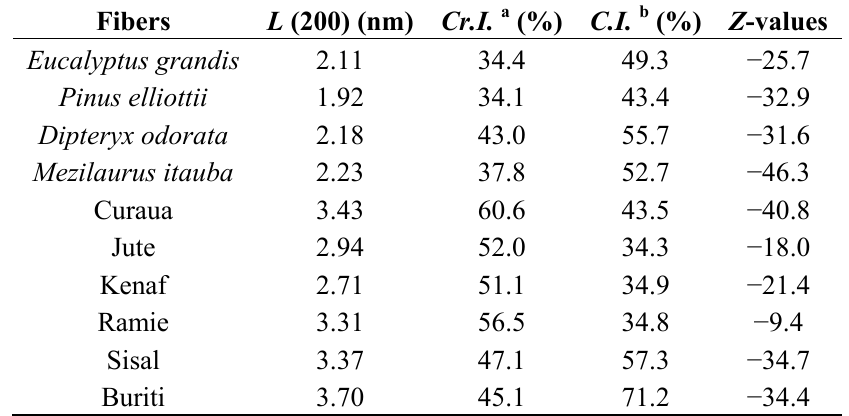
Table 4. Parameters obtained from the XRD analysis of the fibers studied.